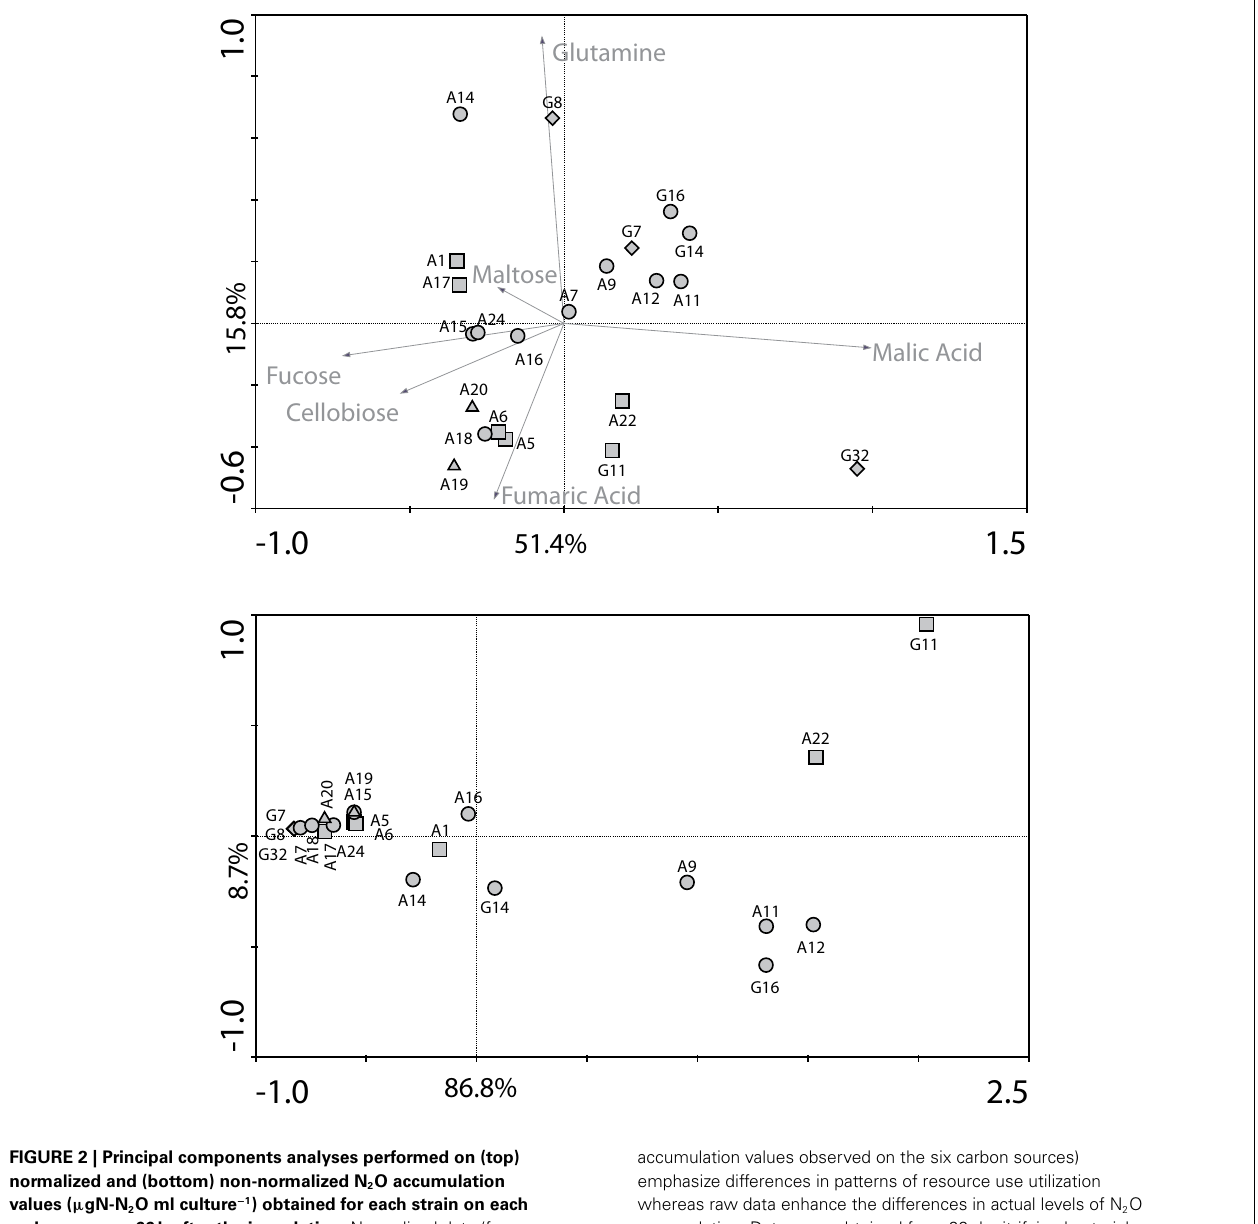
accumulation values observed on the six carbon sources) emphasize differences in patterns of resource use utilization whereas raw data enhance the differences in actual levels of N 2 O accumulation. Data were obtained from 22 denitrifying bacterial strains. Symbols as in Figure 1